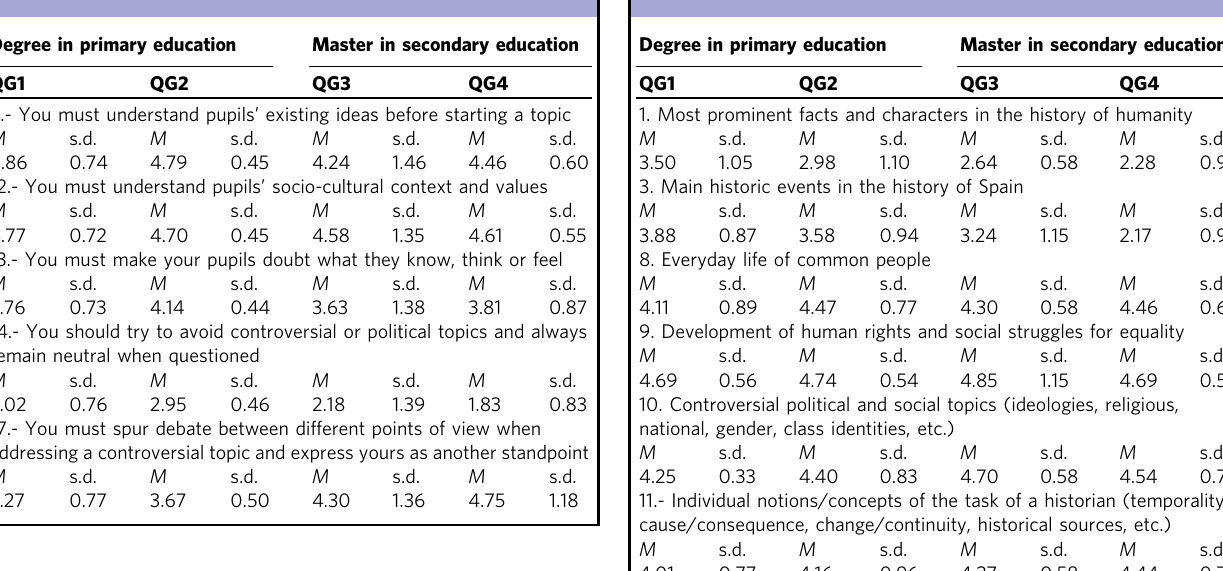
Table 5 Descriptive statistics regarding the content of